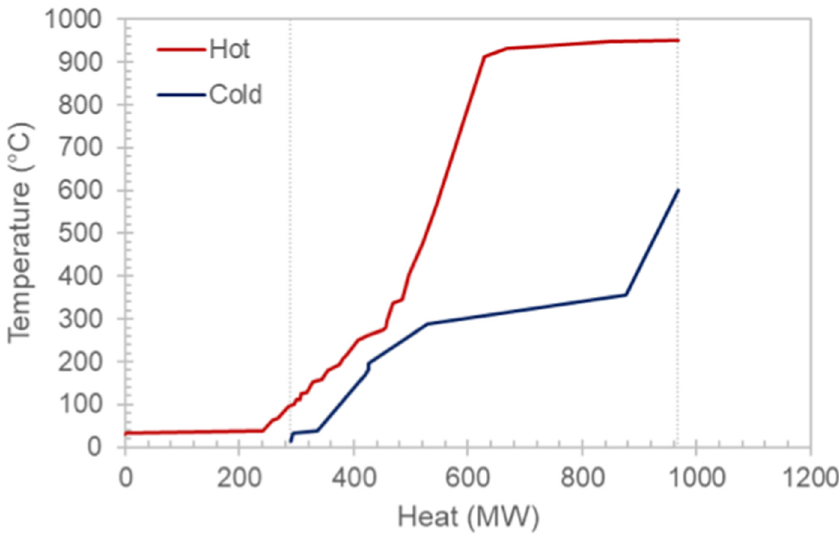
Figure 5. Heat exchange composite curves (petcoke case).